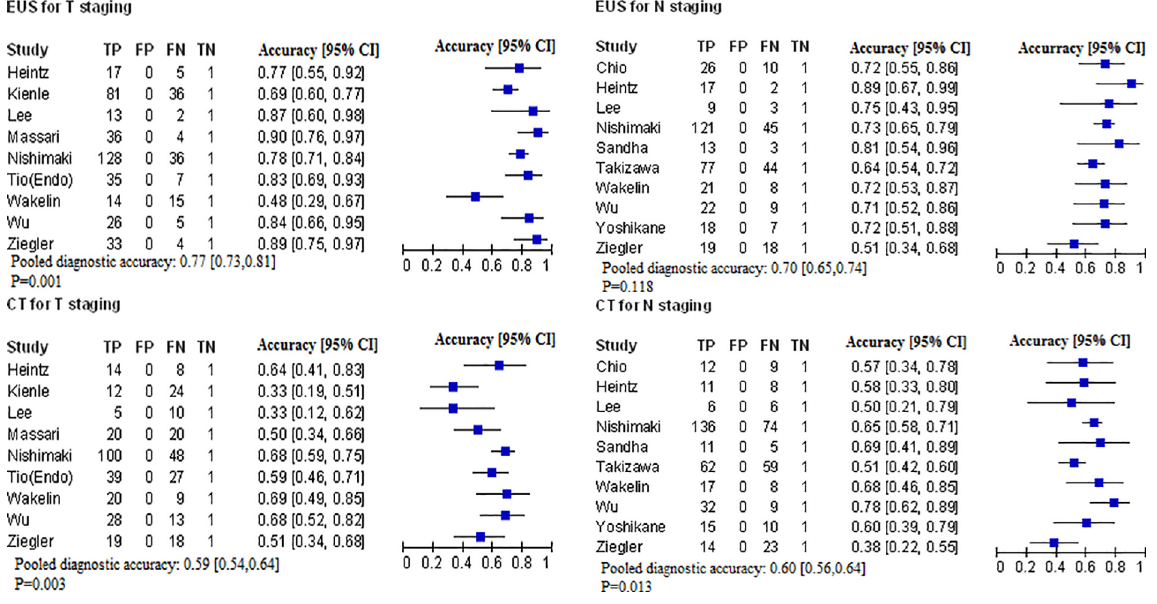
Fig 5. Diagnostic accuracy of EUS versus CT for ESCC.